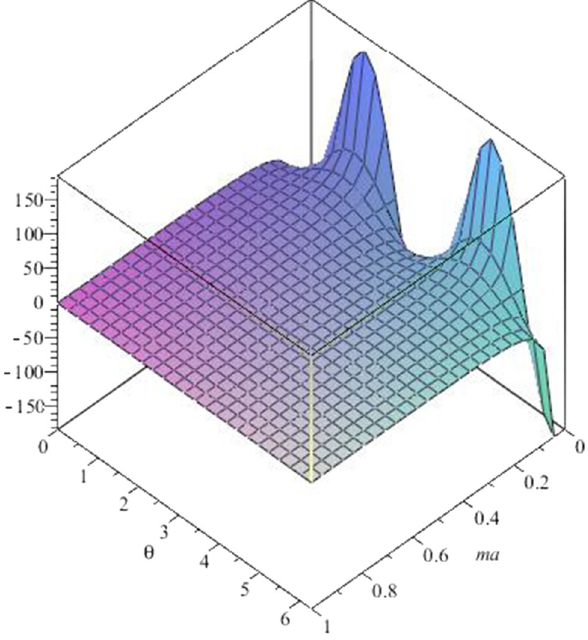
Fig. 2 Plot for the torque in (20), τ TT /( m 2 V x U y